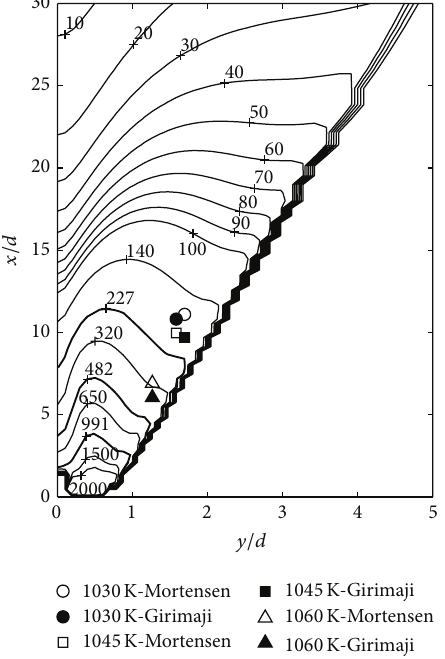
Figure 10: Contours of 𝜒 ∘ (see (30)). The thick contours correspond to 𝜒 ∘ = 𝜒 ∘,𝑐 for 𝑇 𝑐 = 1030 K (227 s −1 ), 1045 K (482 s −1 ), and 1060 K (991s −1 ). The symbols represent the ignition